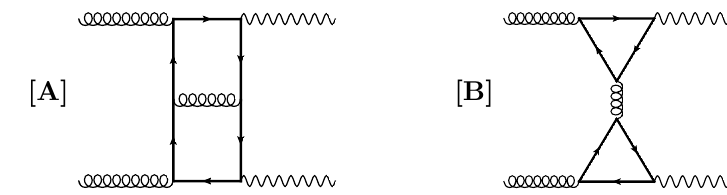
Figure 1. Example Feynman diagrams representing the two classes of